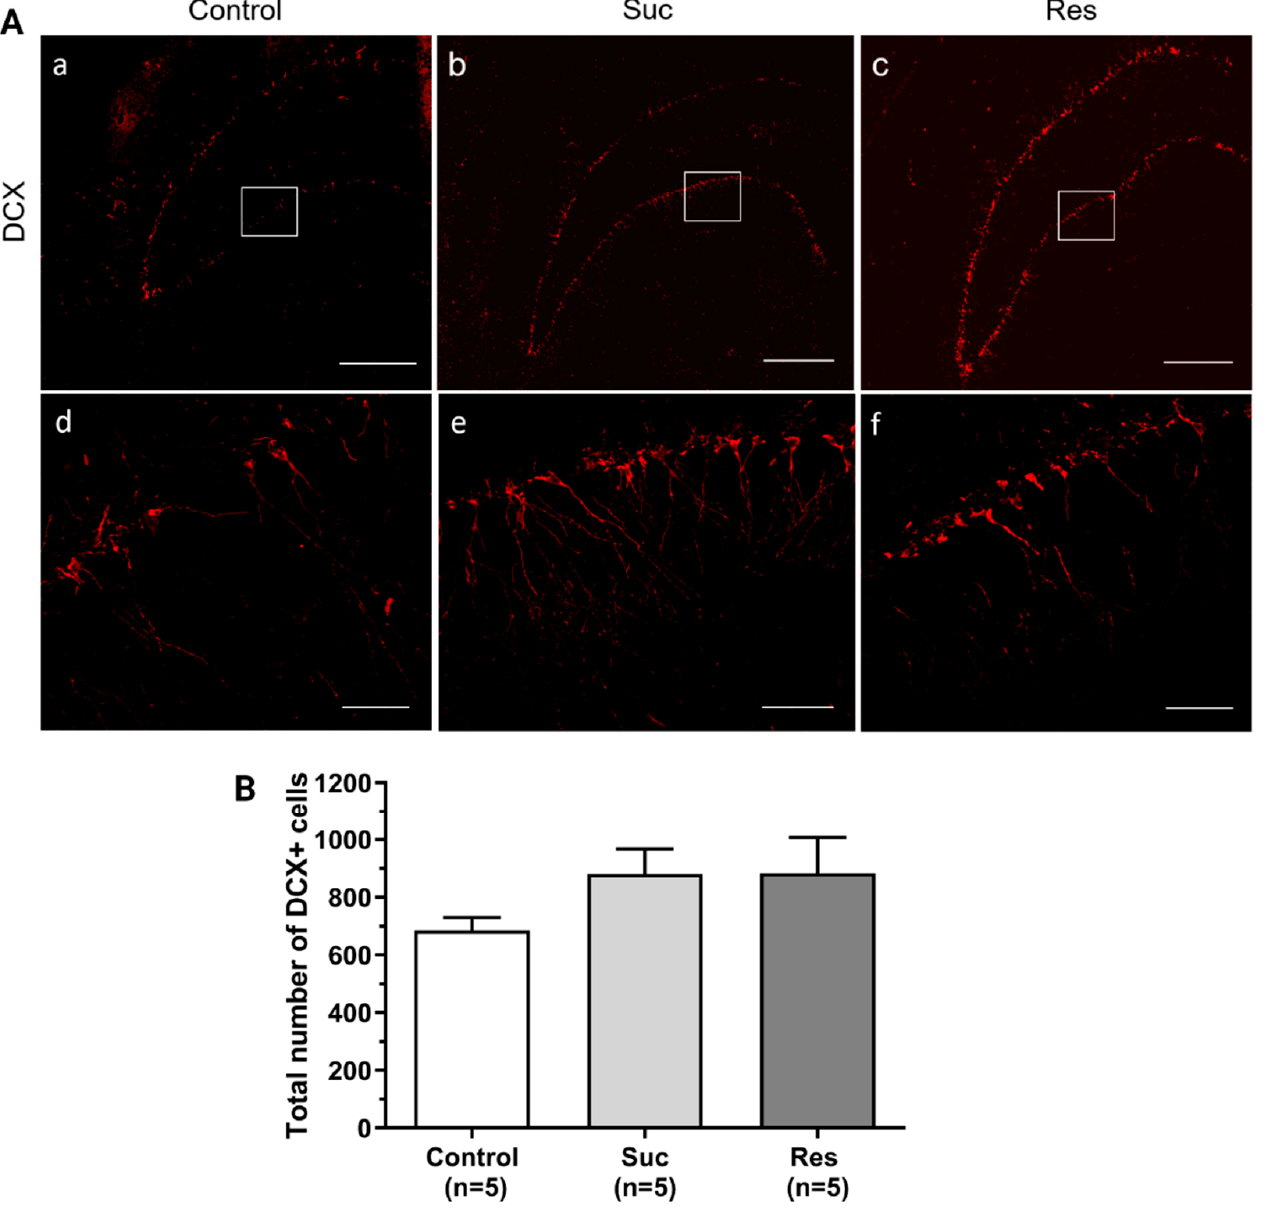
Figure 6. Sucrose consumption does not modify the total number of doublecortin (DCX)-immunoreactive cells in the ventral dentate gyrus. ( A ) Representative confocal photomicrographs showing the presence of DCX+ cells (red) in the ventral dentate gyrus in the control (a), Suc (b) and Res (c) groups. A higher magnification of the zones enclosed within white boxes is shown for the control (d), Suc (e) and Res (f) groups. ( B ) Cell counting of the total DCX+ cells located in the dentate gyrus of the ventral hippocampus. Although the Suc and Res groups showed a tendency to increase the total number of DCX+ cells, no significant differences were found. One Way ANOVA. Scale bar (a–c): 500 µm, scale bar (d–f): 50 µm.